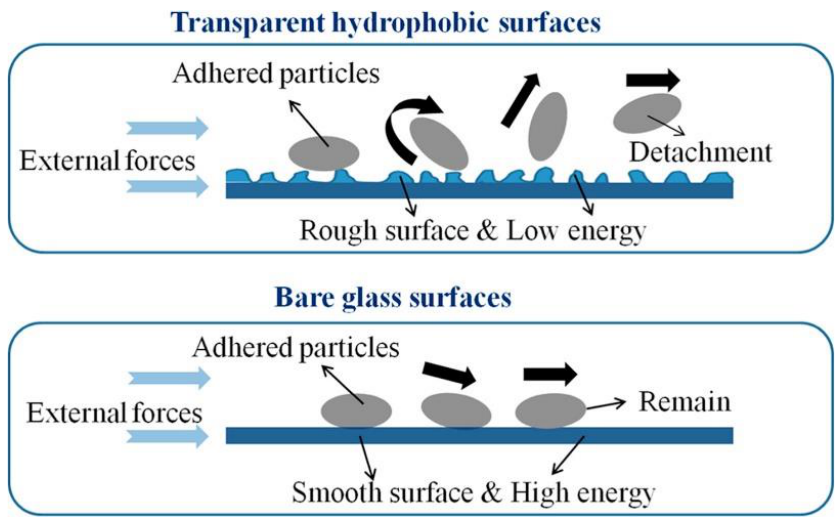
Figure 4. Comparison of dust removal from a superhydrophobic surface and a normal glass surface, reproduced with permission from Ref. [47].